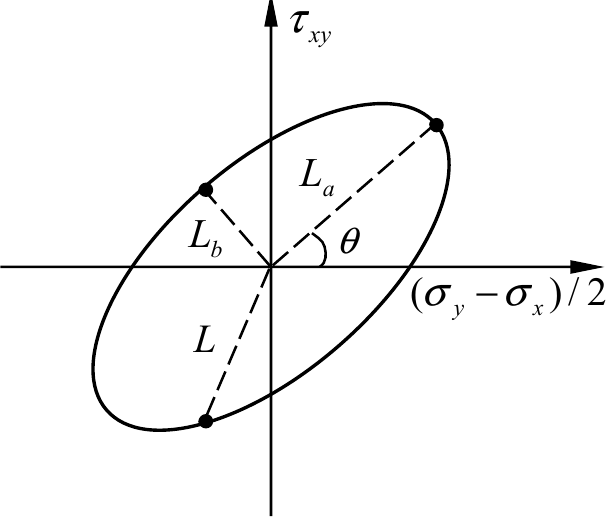
Figure 4. Geometric characteristic parameters of inclined ellipse.